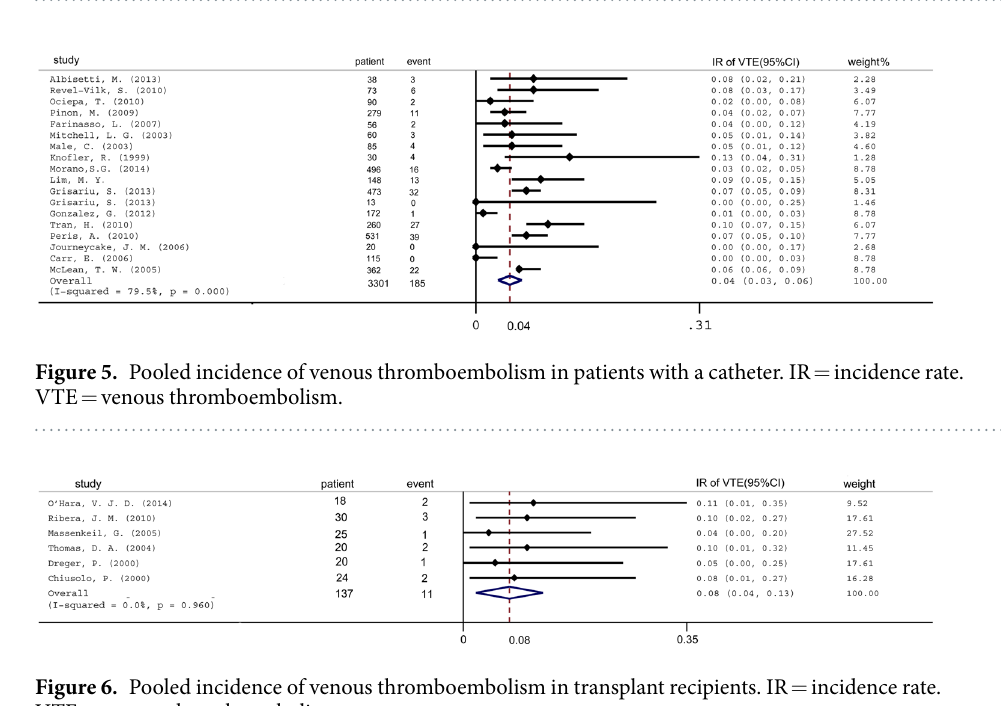
Figure 4. Pooled incidence of venous thromboembolism after receiving prophylaxis. IR = incidence rate. VTE = venous thromboembolism.